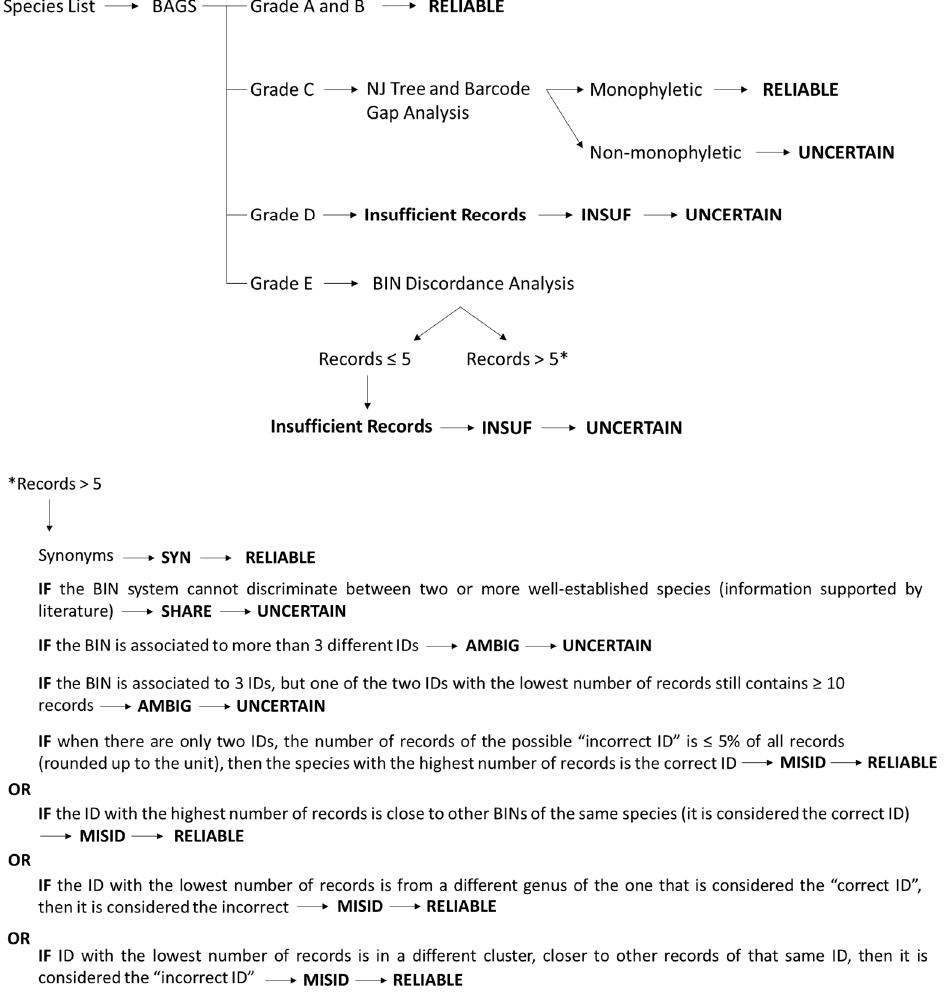
Figure 1. Workflow designed for the curation and audit of BAGS-graded BINs. A list of marine non- indigenous invertebrates was submitted to BAGS that produced a library of graded morphospecies. A set of criteria was developed to tag the BINs associated with the morphospecies as SYN (in case of synonyms), SHARE (if the BIN system cannot discriminate between well-established species), MISID (misidentifications), or AMBIG (ambiguous records). Final RELIABLE or UNCERTAIN tags defined whether the morphospecies identification (ID) matched to each BIN was considered reliable or uncertain.* workflow used for grade E species and with more than 5 records in the BIN discordance